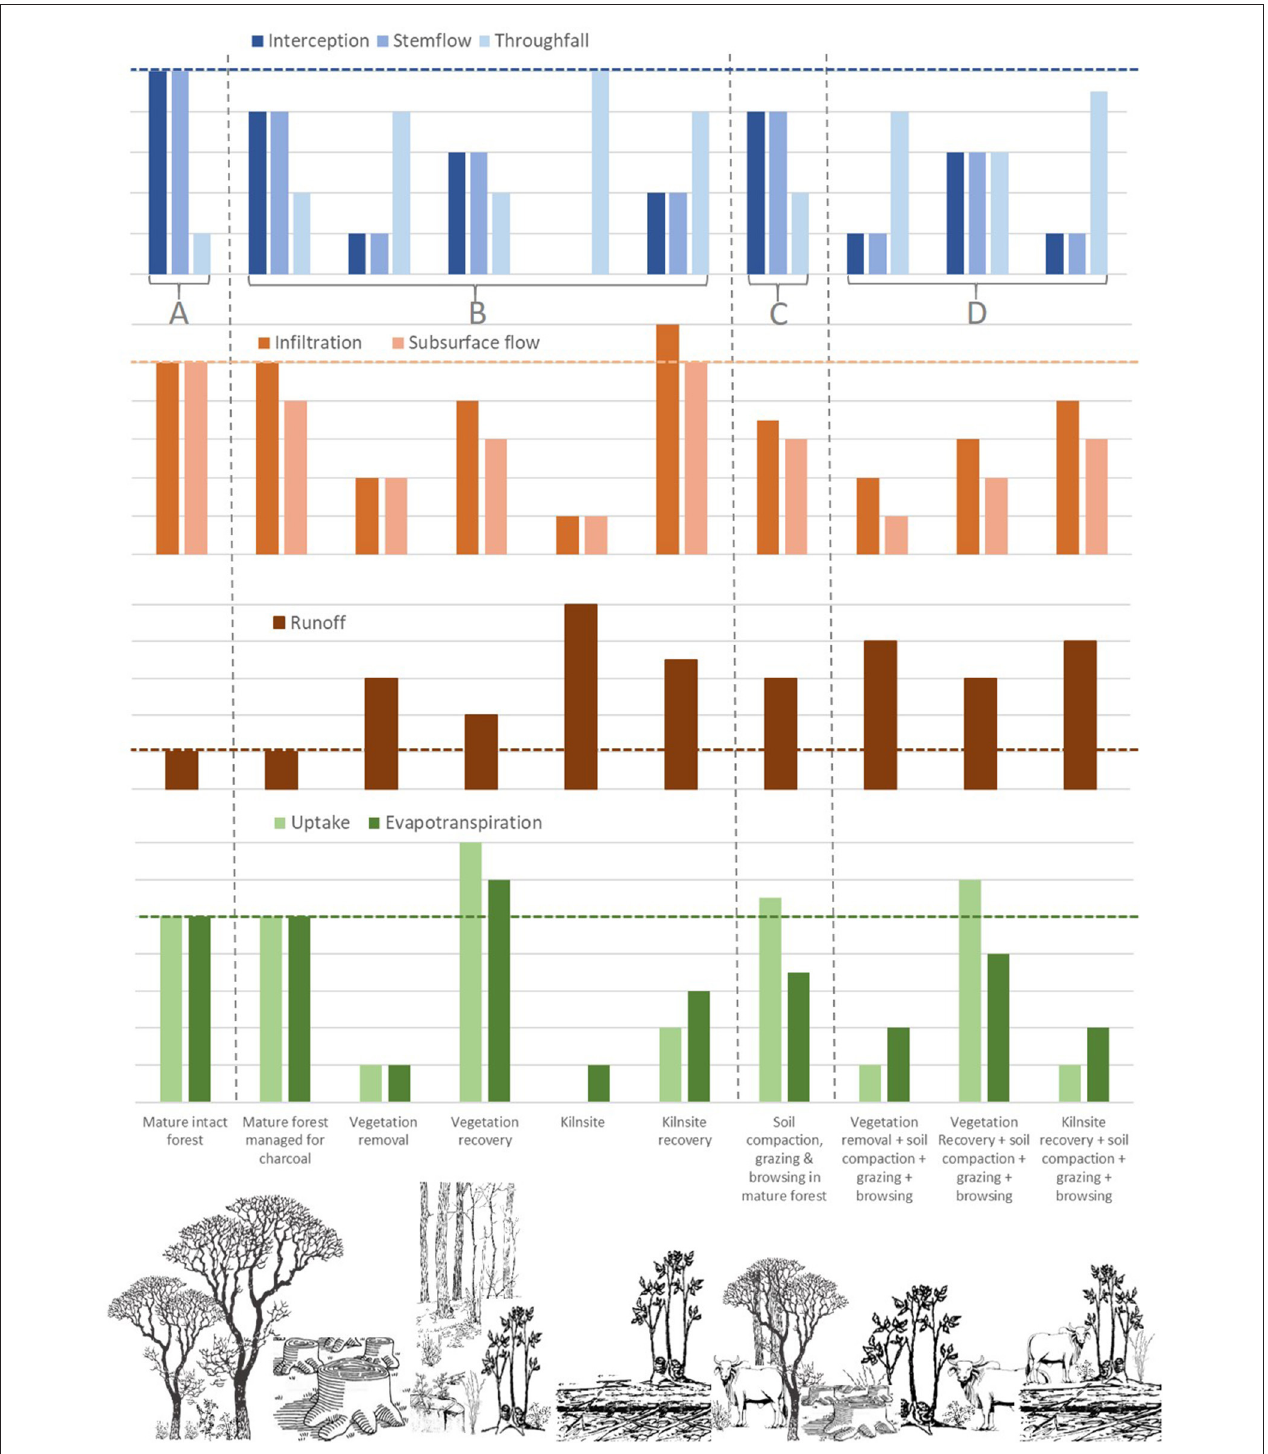
FIGURE 3 | Hypothetical comparison of how key hydrological processes would change relative to (A) mature intact forests (far left bars), (B) during each stage of the production cycle in forests managed solely for charcoal (next five bars), (C) in forests managed only for livestock, and (D) in forests managed for both charcoal and livestock. Changes in hydrological processes are assessed relative to levels in mature forests (horizontal dotted line) and not relative to each other. Grazing intensity is assumed to be medium to high.